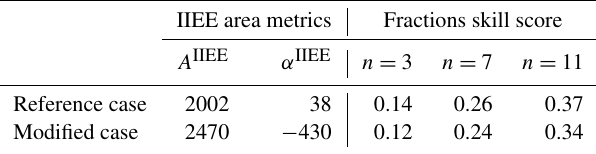
Table 2. Supplementary metric scores. IIEE area scores are given in non-dimensional grid units. The fractions skill score is computed by Eq.